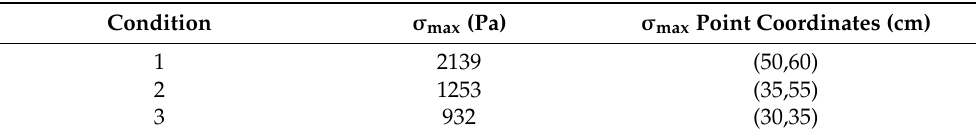
Table 3. Distribution of σ max points under three operating